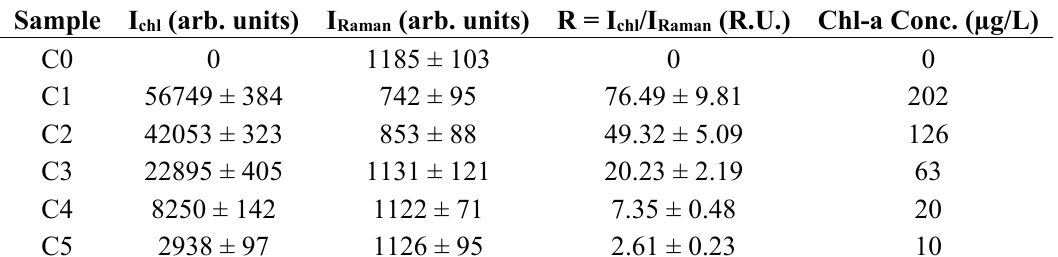
Figure 12. Laboratory calibration: ( a ) spectra of Milli-Q water (C0) and five different concentrations of Chl-a in Milli-Q water (C1—most concentrated to C5—less concentrated); ( b ) graphical representation of the calibration data. Table 2. Chl-a calibration results.